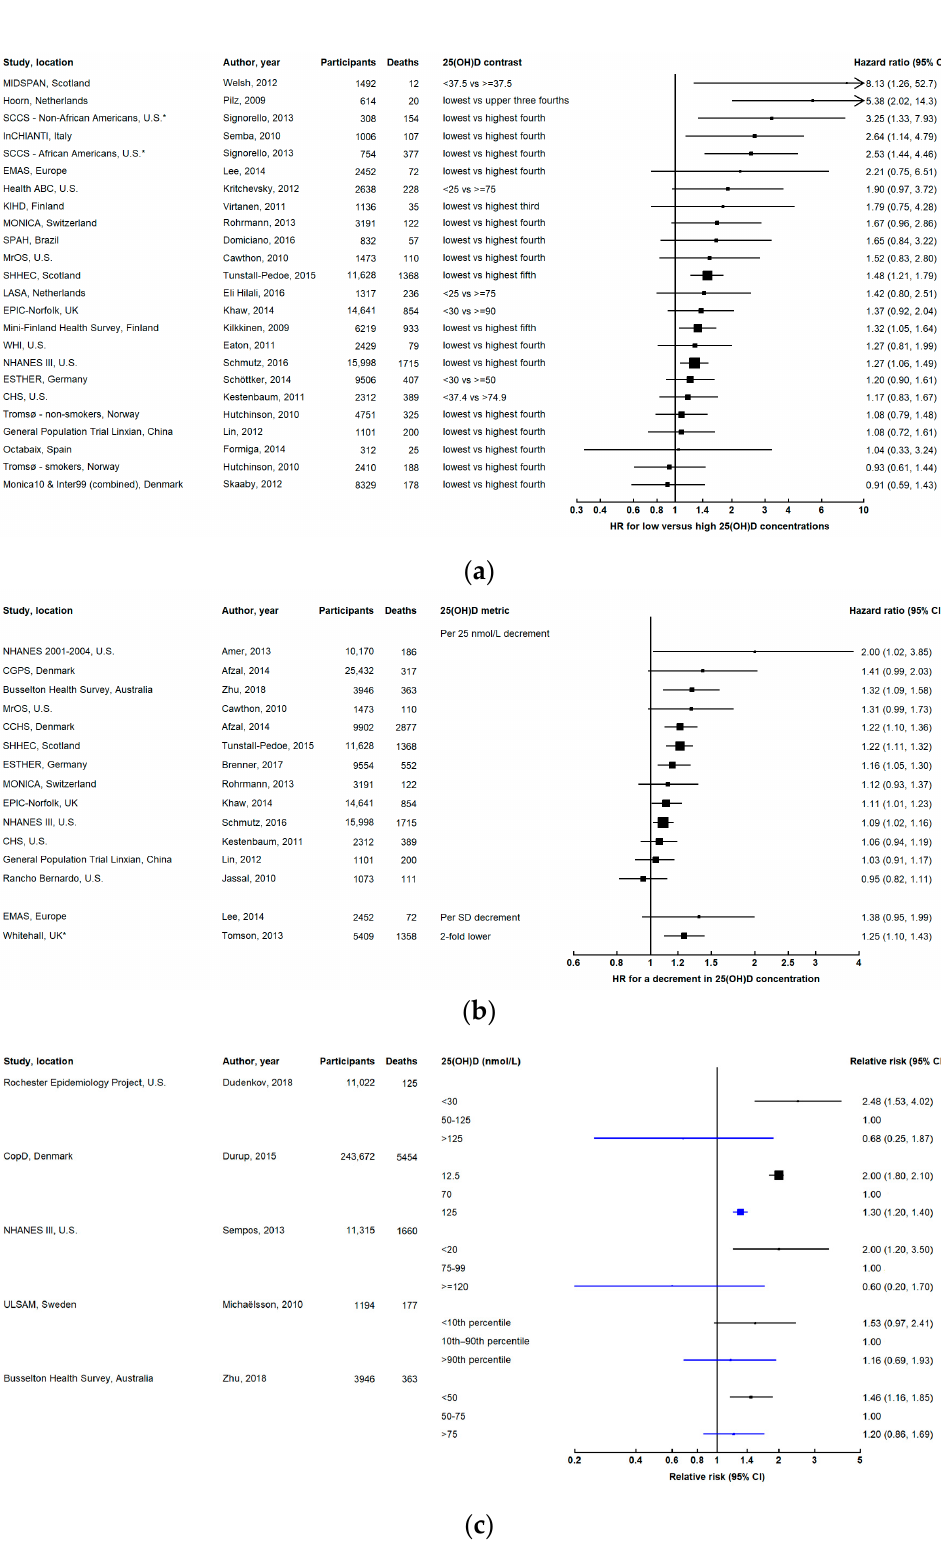
Figure 3. Results from prospective studies investigating cardiovascular mortality in relation to 25-hydroxyvitamin D (25(OH)D) concentration: ( a ) comparing low versus high concentrations categorically; ( b ) continuously, for a decrement in 25(OH)D concentration; ( c ) low (black) and high (blue) concentrations compared with levels in the middle of the 25(OH)D distribution. The squares represent hazard ratios and horizontal lines are the 95% confidence intervals. Studies that estimated odds ratios or relative risks are denoted by * and ˆ, respectively. Axes are scaled differently in each panel to maximize the visualization of effect